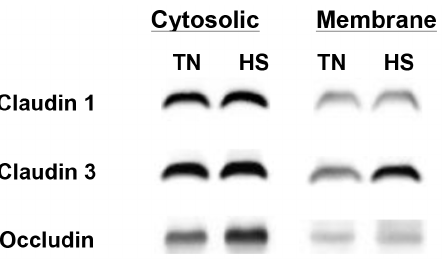
Figure 3. Heat stress conditions (HS; 35 u C) increases serum endotoxin compared to pigs reared in thermal neutral conditions (TN; 21 u C) for 24 hours. a,b P , 0.05, n=8/trt.